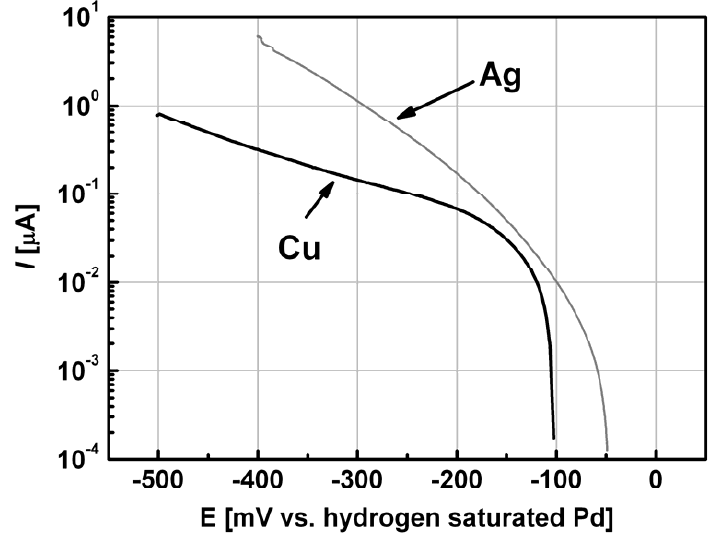
Fig. 2 Polarization curves of Ag (grey line) and Cu (black line) microelectrodes, carried out with 5 mV/s sweep